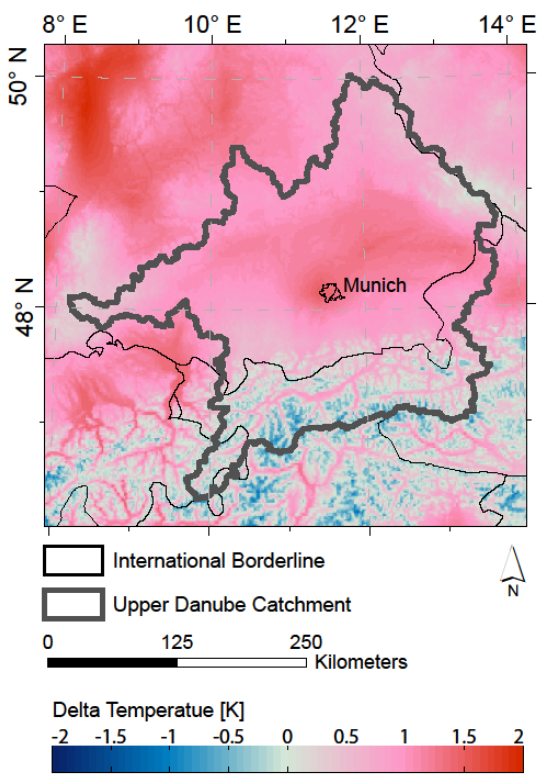
Figure 5: Difference plot between 2-way coupled PROMET/MM5 and NOAH/MM5 annual Fig. 5. Difference plot between 2-way coupled PROMET/MM5 and NOAH/MM5 annual mean near-surface air temperature in the Up- mean near surface air temperature in the Upper Danube catchment, downscaled to 1 km by per Danube catchment, downscaled to 1km by using SCALMET. using SCALMET.